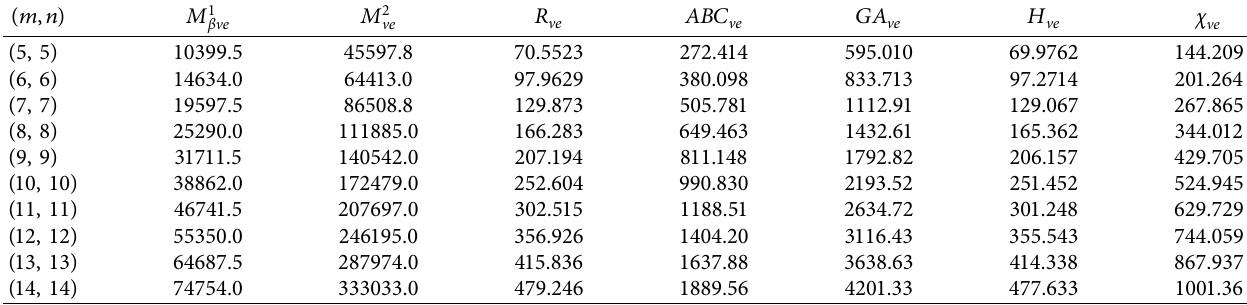
Table 8: Numerical comparison of M 1